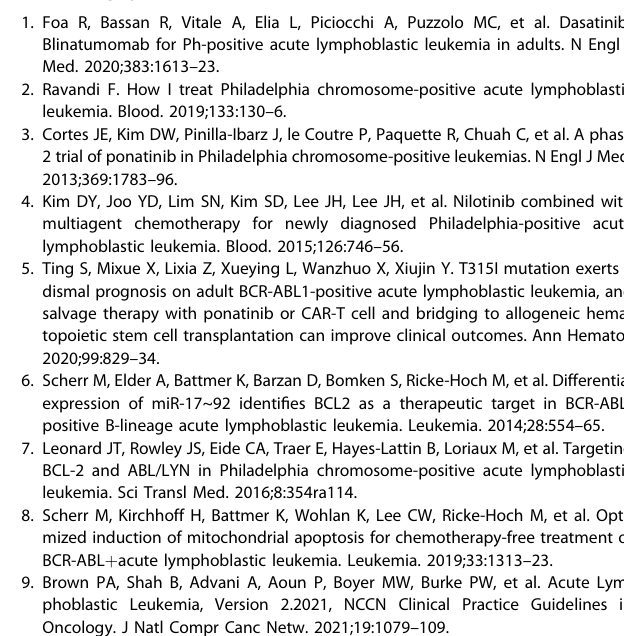
or compound mutations are listed in Table S3. In summary, the VPD regimen provides a novel treatment for T315I/compound- mutated R/R Ph + ALL under a complete oral and chemo-free model. A clinical trial also using a similar VPD regimen for the treatment of R/R Ph + ALL is ongoing now, and the results of a phase 1 portion of this study including nine patients also showed that the combination of ponatinib, venetoclax, and dexametha- sone in R/R Ph + ALL is safe and effective [12].